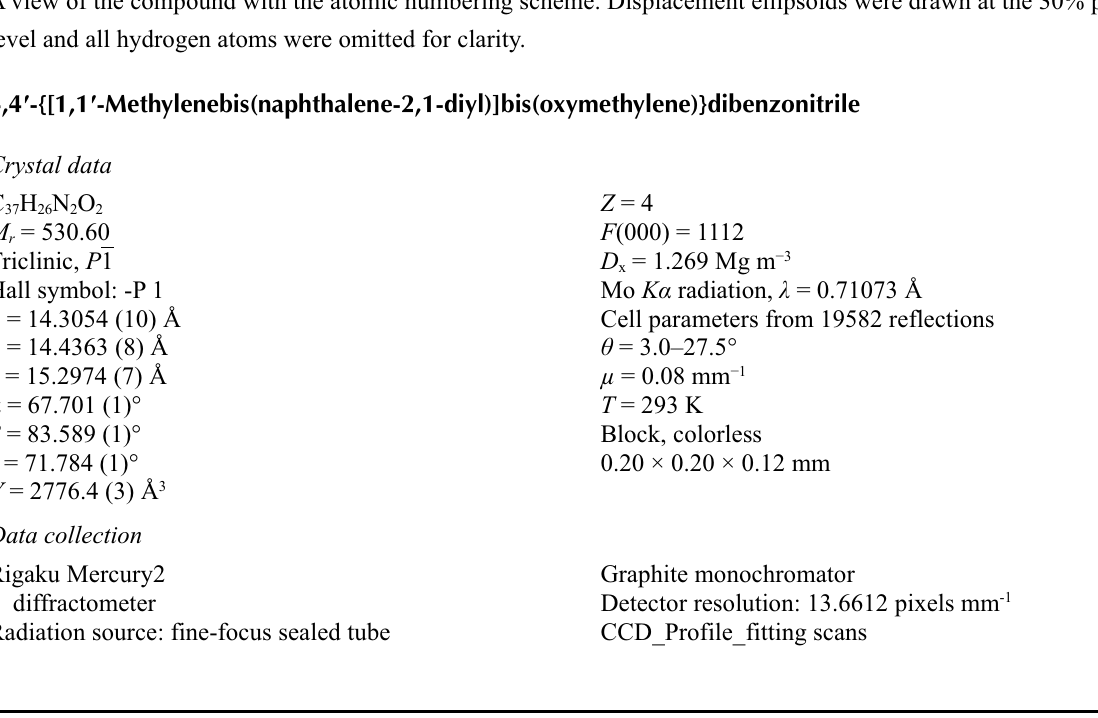
A view of the compound with the atomic numbering scheme. Displacement ellipsoids were drawn at the 30% probability level and all hydrogen atoms were omitted for